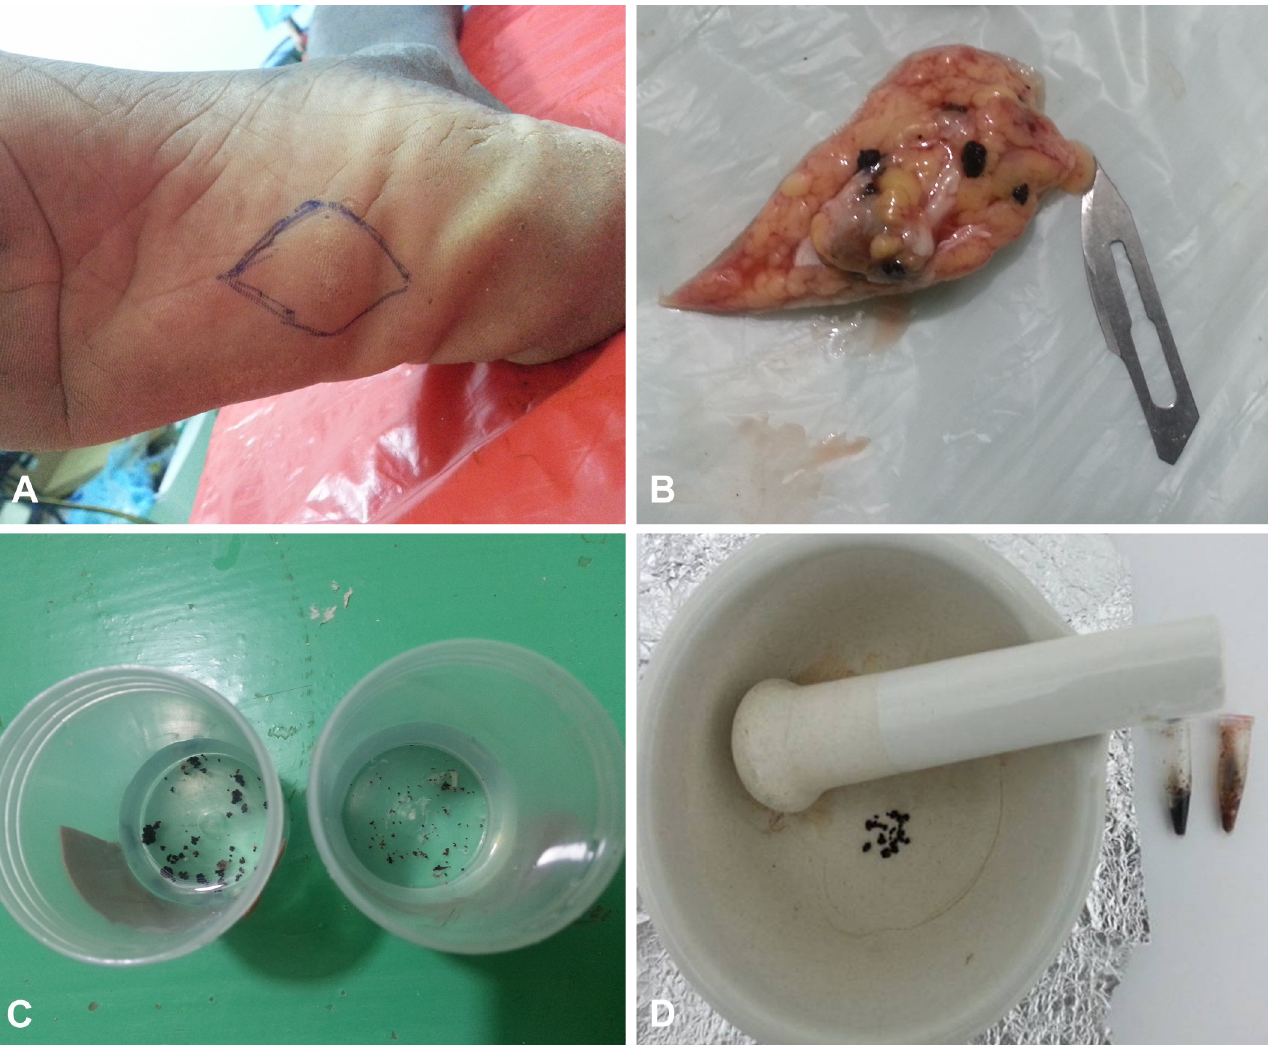
Fig 1. Sample collection and homogenization (A) Mycetoma lesion, (B) Deep excised biopsy, (C) Black-grains specimen, (D) Manual homogenization of the black-grains.